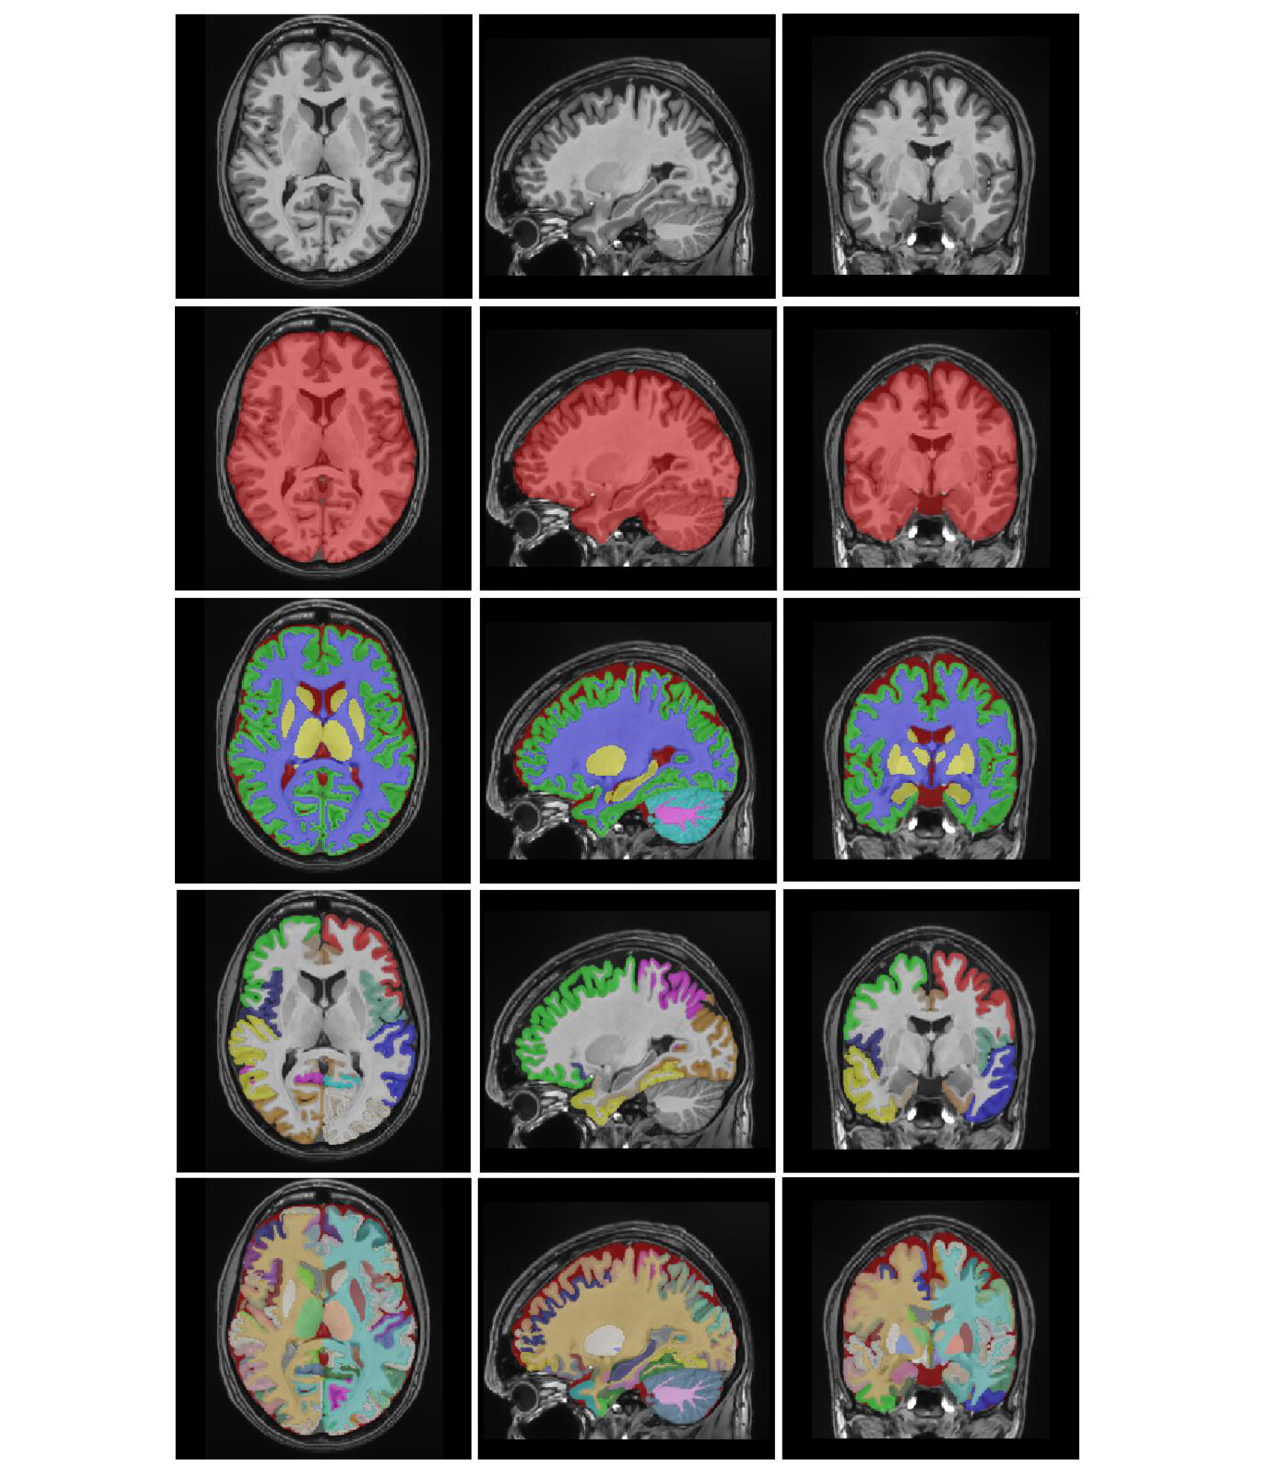
FIGURE 4 | Example results of vol2Brain. T1 image, ICC mask, brain tissues, lobes, and structures.